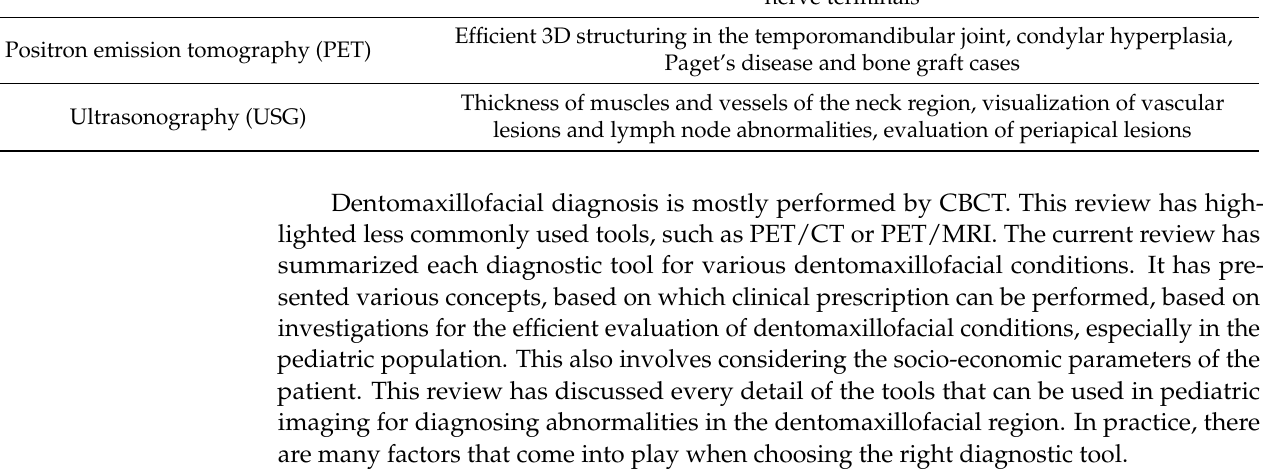
Table 1. Investigative tools for the diagnosis of various dentomaxillofacial abnormalities. Investigative Tool Condition Likely to Be Diagnosed Effectively Planning of dental implants, visualization of abnormal teeth, evaluation of jaws and face, assessment of cleft palate, dental caries diagnosis, endodontic diagnosis, and diagnosis of dentomaxillofacial